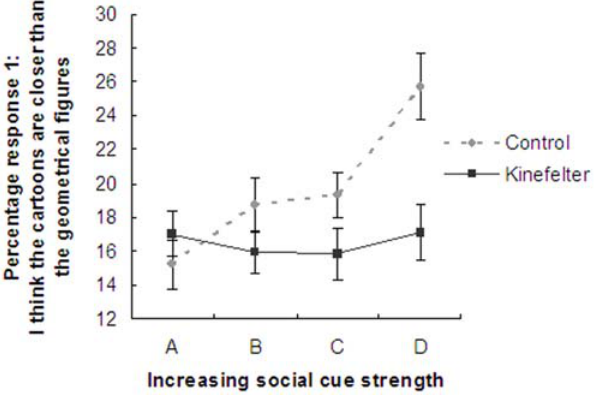
Figure 3. Linear increase in response 1 (‘‘Cartoons Closer’’) consistent with social cue strength in healthy control men, but not in Klinefelter men.